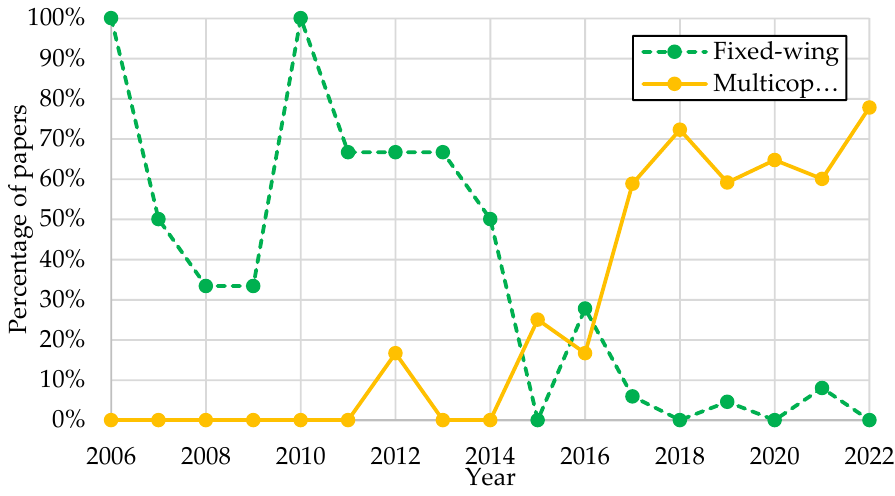
Figure 17. Type of UAS per year.